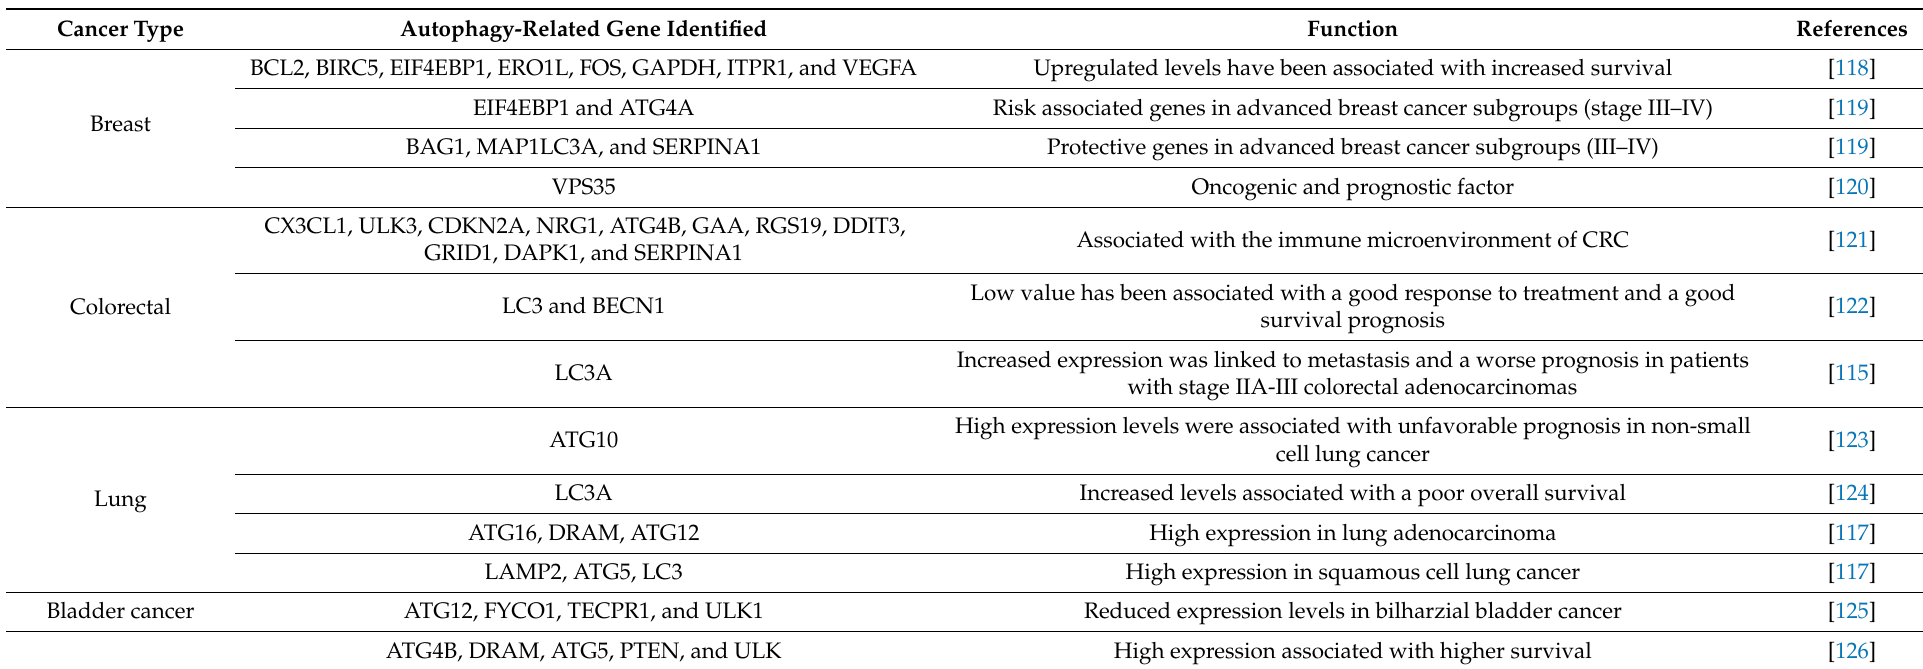
Table 1. Autophagy-related gene signature in breast, colorectal, bladder, and lung